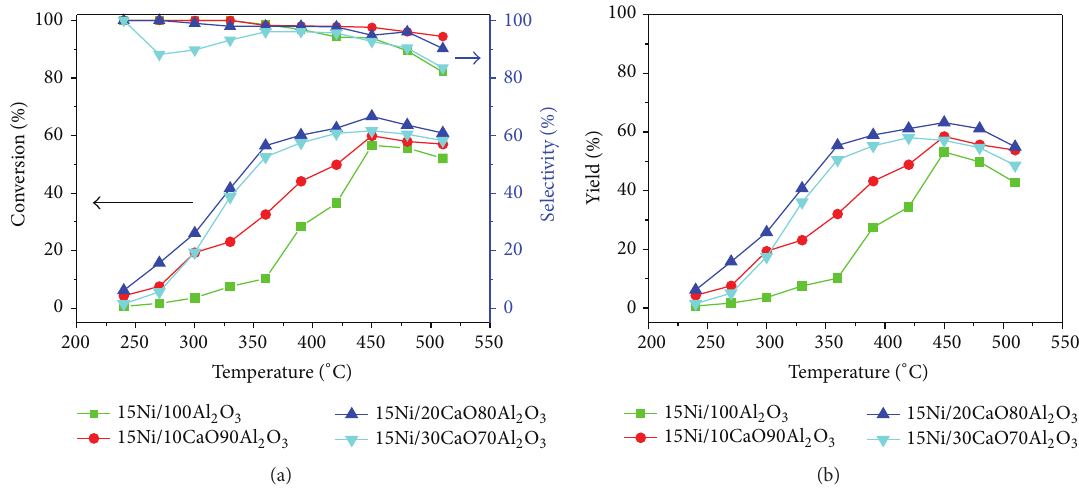
Figure 7: CO 2 conversion and CH 4 selectivity (a) and CH 4 yield (b) versus reaction temperature over the